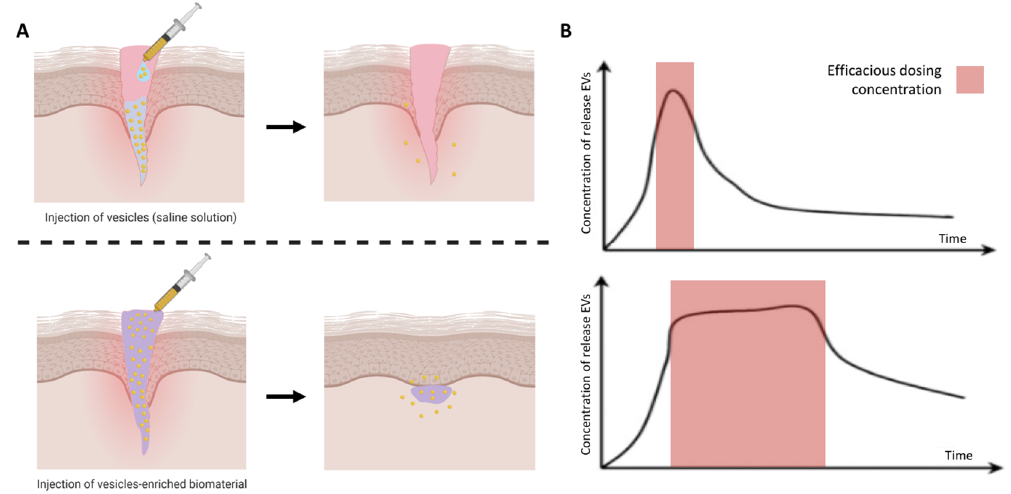
Figure 6. Therapeutic administration of EVs to the site of injury. ( A ) Schematic representation of the local delivery of EVs within an injectable biomaterial resulting in increased retention and therapeutic efficacy compared to delivery in solution. ( B ) Release kinetics of EVs from different delivery strategies. Burst release of EVs delivered in solutions, while sustained delivery observed from EV-